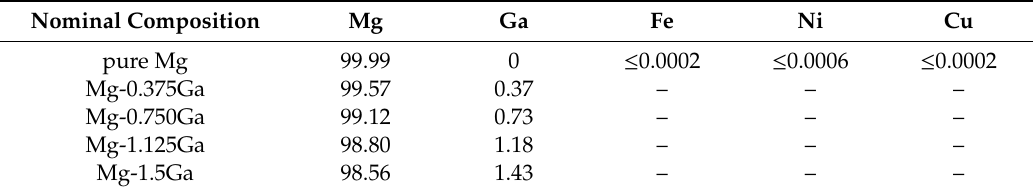
Table 1. Chemical composition (wt. %) of pure Mg and Mg-Ga alloys (as-cast). Nominal